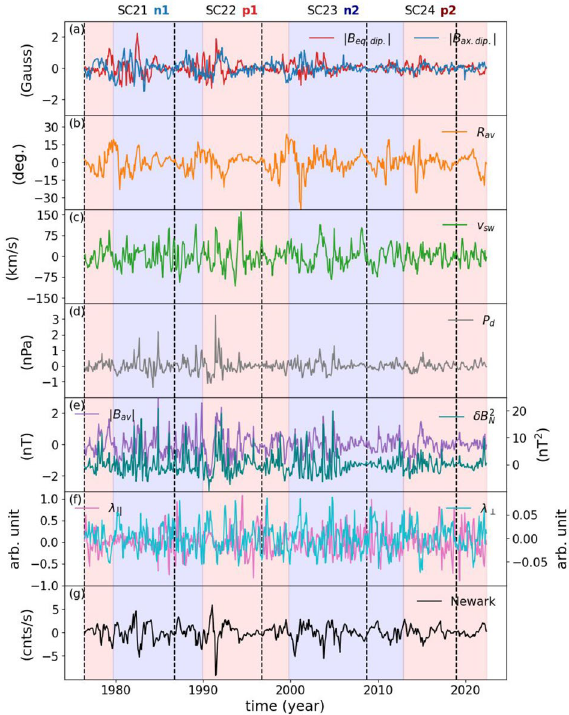
Figure 3. Same as Fig. 1 but high-pass filtered using a cut-off frequency of 5 year − 1